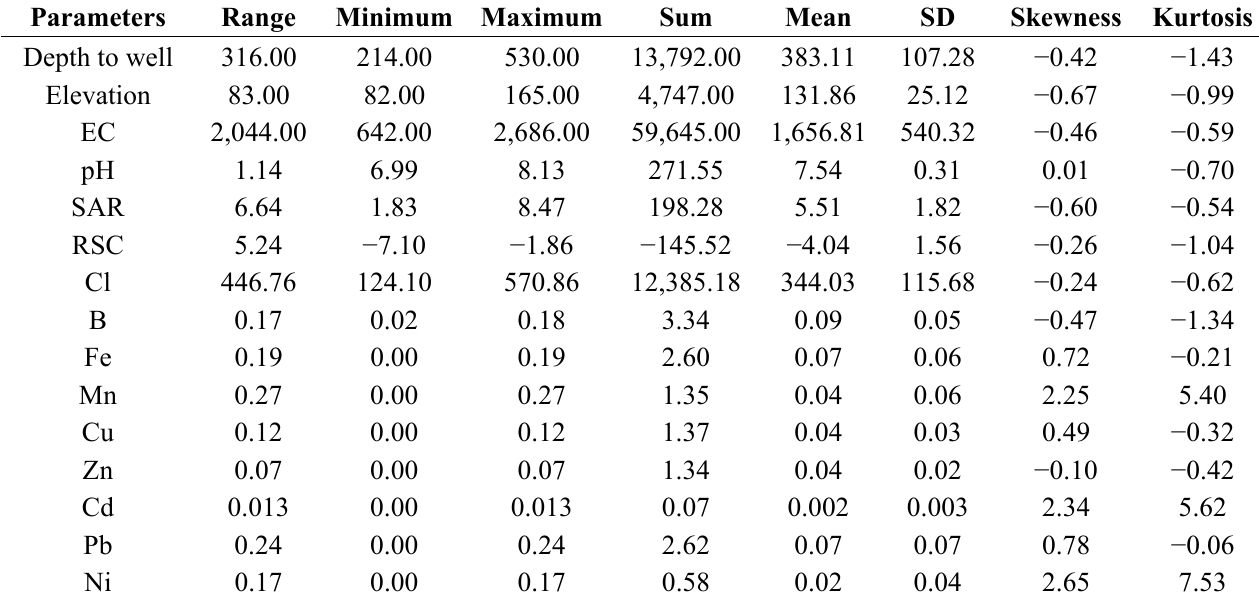
Table 3. Descriptive statistics of water quality parameters of water